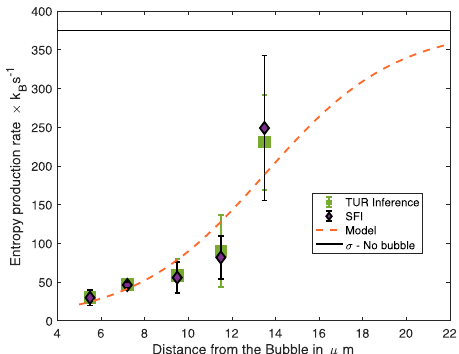
Fig. 6 Inference scheme tested in the presence of the bubble. Short-time thermodynamic uncertainty relation (TUR) and stochastic force inference (SFI) estimates for the entropy production rate in the colloidal system in the presence of the bubble, as a function of the distance from the surface of the bubble. The values of σ inferred with the short-time TUR (green squares), the SFI (purple diamonds), and the ad-hoc model in Eq. (16) (red dashed line) are in good agreement. The fi t parameters, de fi ned in Eq. (17) used for the free parameters in the model are, a = 282.743 and b = 1/ 3 μ m − 1 . Note that a is dimensionless. The error estimates are standard deviations over an ensemble of 6 trajectories, each of length 10 s and sampling interval Δ t = 0.0001 s, for both the schemes. The parameters used in the experiment are as follows: the corner-frequency of the harmonic trap, f c = 135 ± 10 Hz, relaxation time of the Ornstein – Uhlenbeck process τ 0 = 0.0025 s, temperature of the aqueous medium T = 298 K and the amplitude of the Ornstein – Uhlenbeck noise A ¼ 0 : 3 ´ ð 0 : 6 ´ 10 (cid:4) 6 Þ 2 m 2 s (cid:4) 1